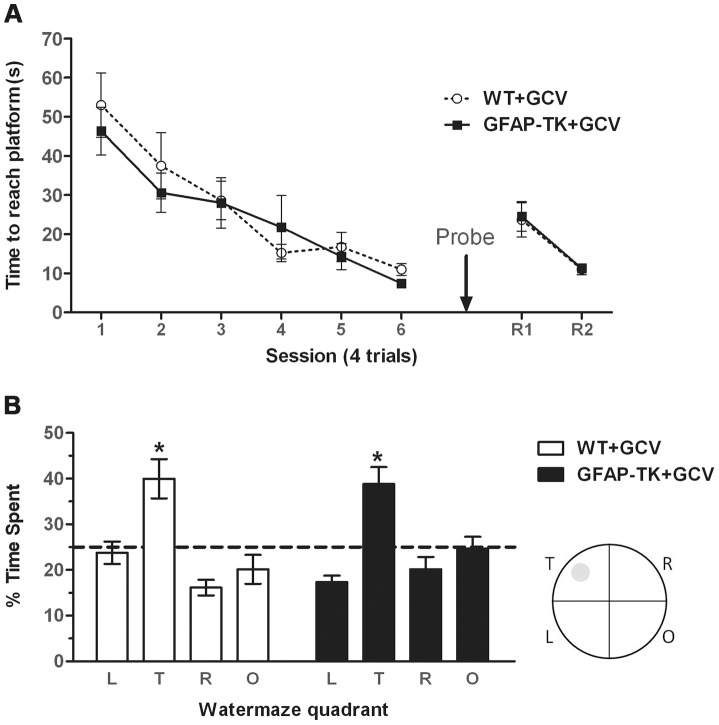
Ablating adult neurogenesis does not affect spatial reference memory in the water maze.
A Time spent swimming to reach a submerged platform by GCV-treated wild type (n = 7) and GFAP-TK (n = 10) rats during the acquisition and reversal phase of a spatial reference memory water maze task. Each data point represents the mean score (±sem) per session (1 session consists of 4×90 second trials). R1/R2 represents a reversal phase, where the platform was moved to the opposite quadrant of the pool. B Percentage time spent swimming in each quadrant by GCV-treated wild type (n = 7) and GFAP-TK (n = 10) rats during the probe trial. L = adjacent left quadrant, T = target quadrant, R = adjacent right quadrant, O = opposite quadrant. Interrupted horizontal line represents a value of chance. Data represent mean % time (±sem) during a 60 s trial. *p<0.05 significantly different from time spent in other quadrants. Wild type data are represented by an open circle connected by an interrupted line, GFAP-TK data are represented by filled squares and a solid line.